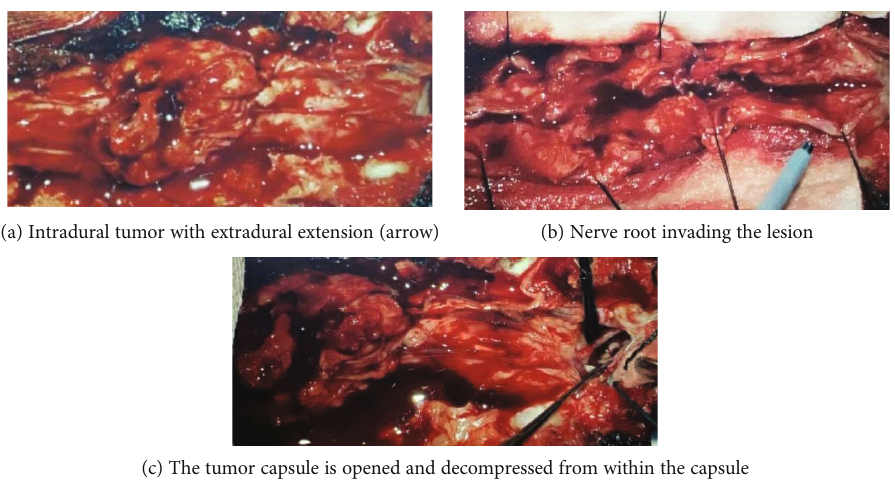
Figure 5: Intraoperative images for spinal tumor